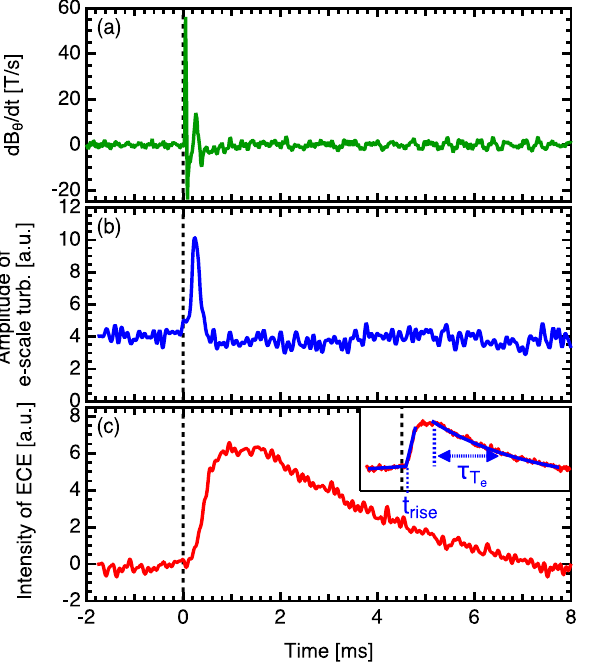
Figure 4. Time evolutions of the ( a ) magnetic fluctuation, ( b ) electron scale turbulence, and ( c ) electron temperature measured using a magnetic probe, W-band back-scattering measurement, and ECE measurement,